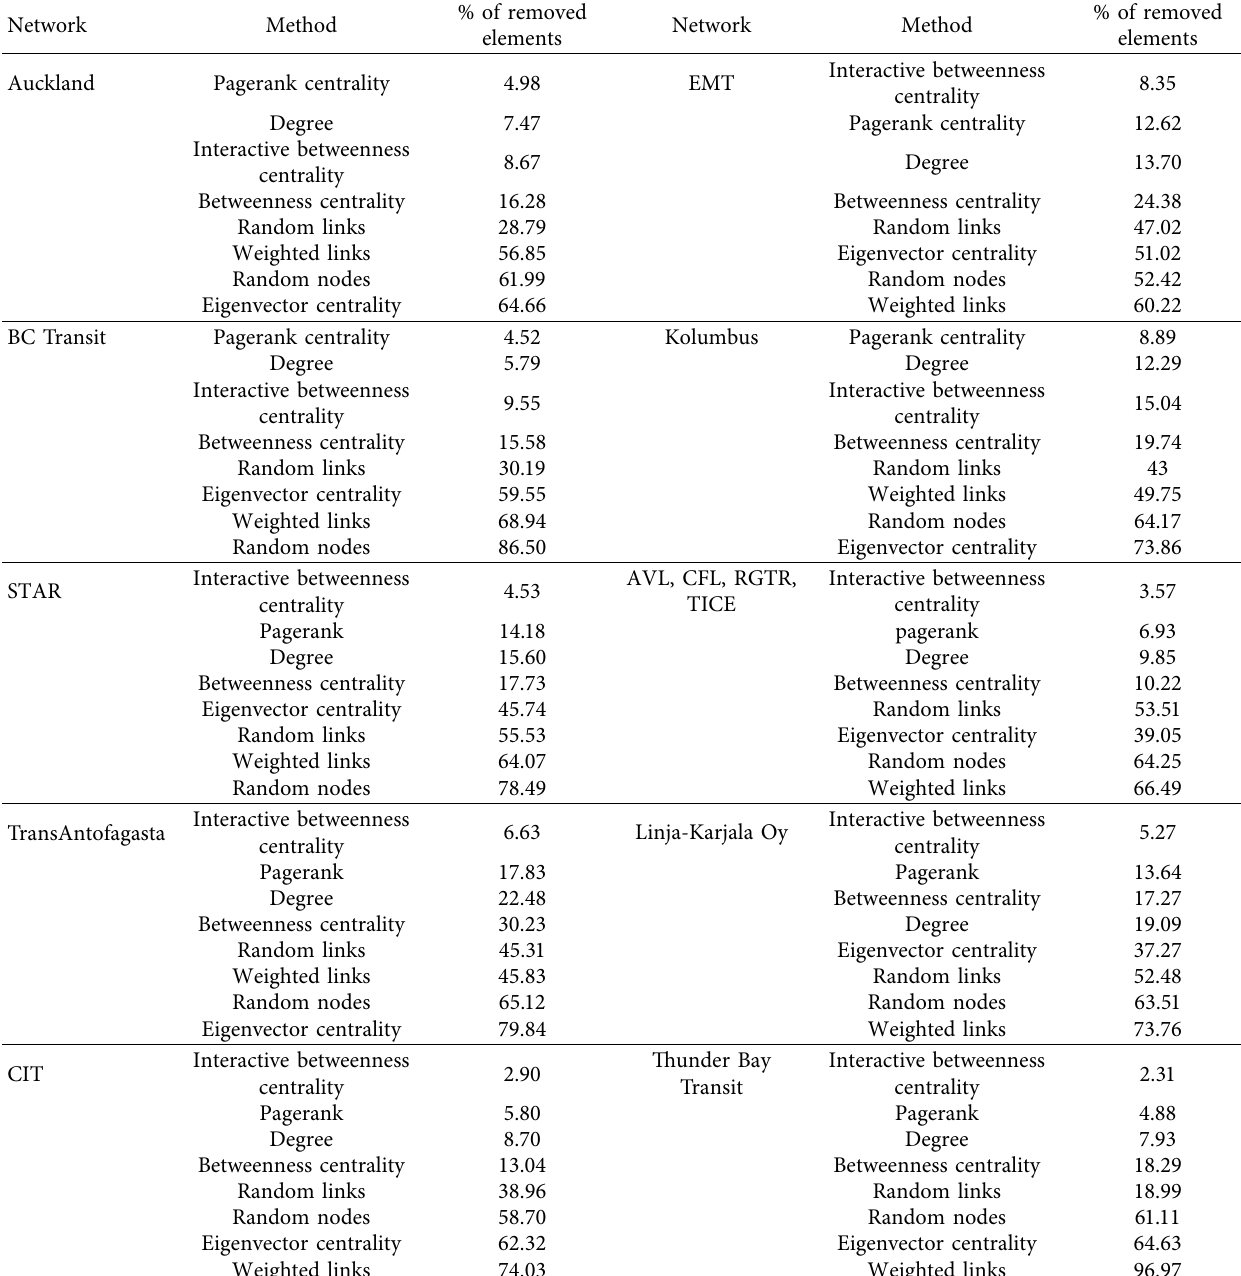
Table 19: Percentage of removed nodes with which the 80% of reduction in the GC is achieved. Network